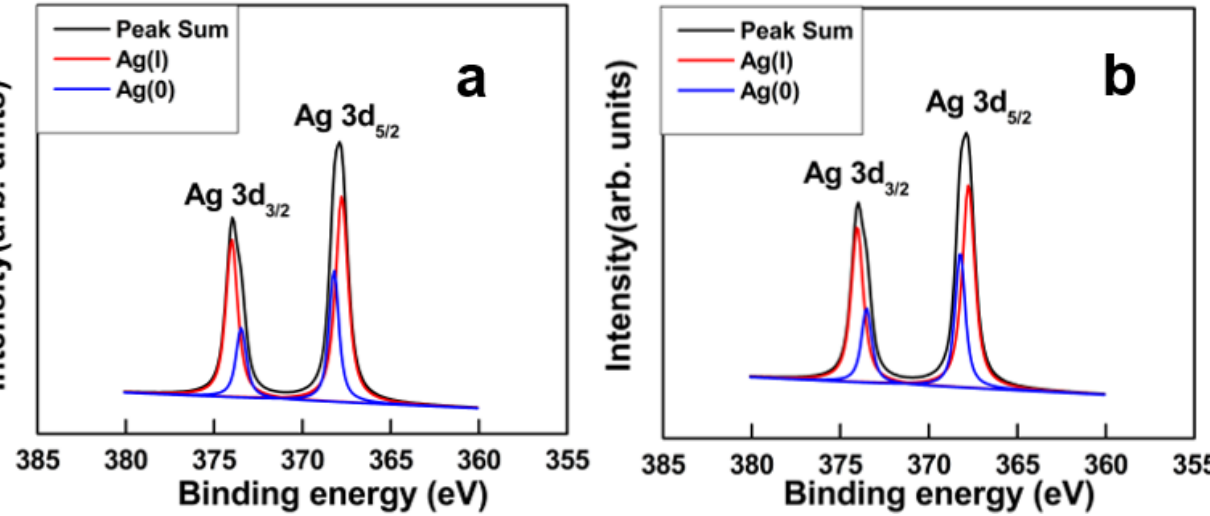
Figure 6. XPS spectra and deconvoluted peaks of Ag3d for GO–Ag NPs ( a ) and GO–Ag NPrsms ( b